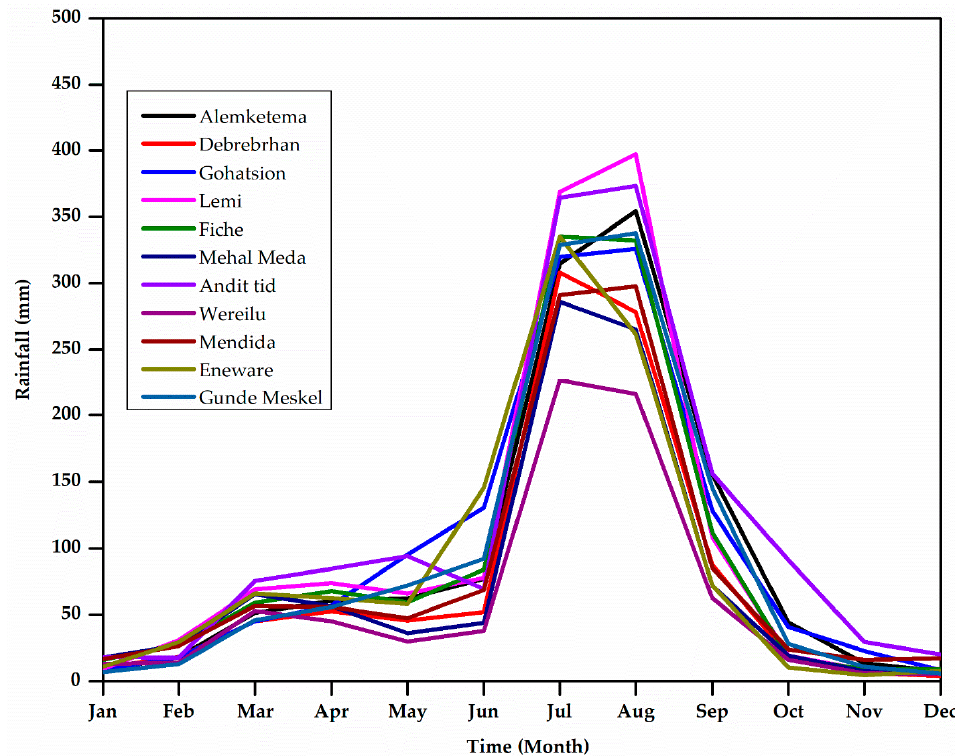
Figure 2. Mean monthly rainfall at weather stations in the Jemma sub-basin.